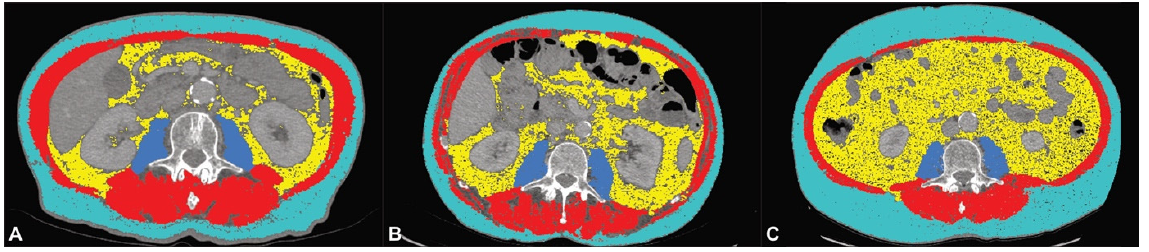
Figure 3. Example segmentations of patients without sarcopenia ( A ), sarcopenia ( B ) and sarcopenic obesity ( C ).